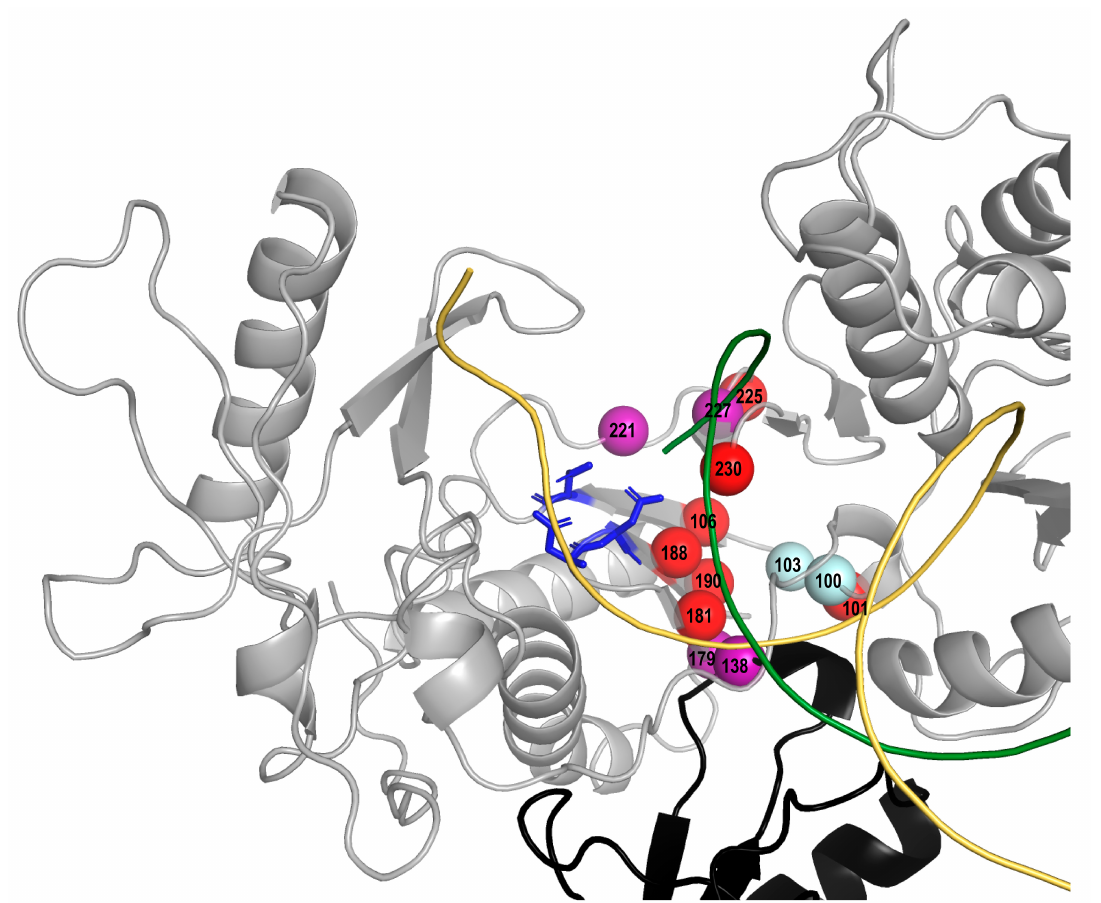
Figure 2. Three-dimensional structure (PDB accession number 1RTD) of HIV-1 RT showing the p66 monomer in grey and the finger domain of the p51 in black. The active site residues D110, D185, and D186 are shown in stick mode in blue, a DNA template and a primer are shown in ribbon mode in yellow and green, respectively. Red spheres indicate seven SDRM positions at which SDRMs including K101E, Y181V, Y188C, G190S, P225H, and M230L increased in prevalence since 2009 in NNRTI-experienced persons. Four spheres in purple indicate positions at which non-SDRMs (E138K/Q, V179L, H221Y, and F227C/L) increased in prevalence since 2009 in NNRTI-experienced persons. Spheres in cyan indicate two SDRM positions at which SDRMs decreased or did not change in prevalence since 2009 in NNRTI-experienced